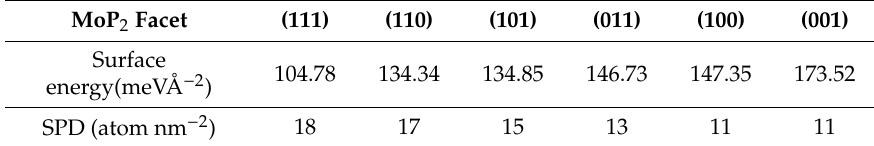
Table 2. Calculated surface energies and surface packing density (SPD) of low Miller-index facets for MoP 2 .